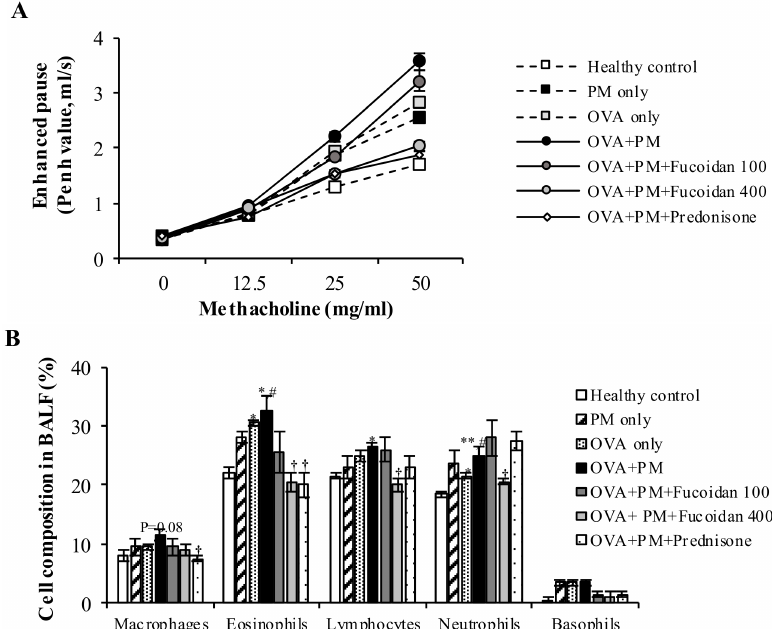
Figure 2. The e ff ect of fucoidans on PM-exacerbated airway hyper-responsiveness and di ff erential cells in the broncho alveolar lavage fluid (BALF). ( A ) Airway hyper-responsiveness is shown as Penh values in response to increasing concentrations of methacholine (0–50 mg / mL). ( B ) The number of inflammatory cells in the BALF. Values are expressed as means ± SEM of at least two individual experiments ( n = 6). * ( p < 0.05), ** ( p < 0.005), represent significant increases compared with the healthy control, and † ( p < 0.05), †† ( p < 0.005), represent significant decreases compared with the OVA + PM group. # represents a significant increase compared with OVA